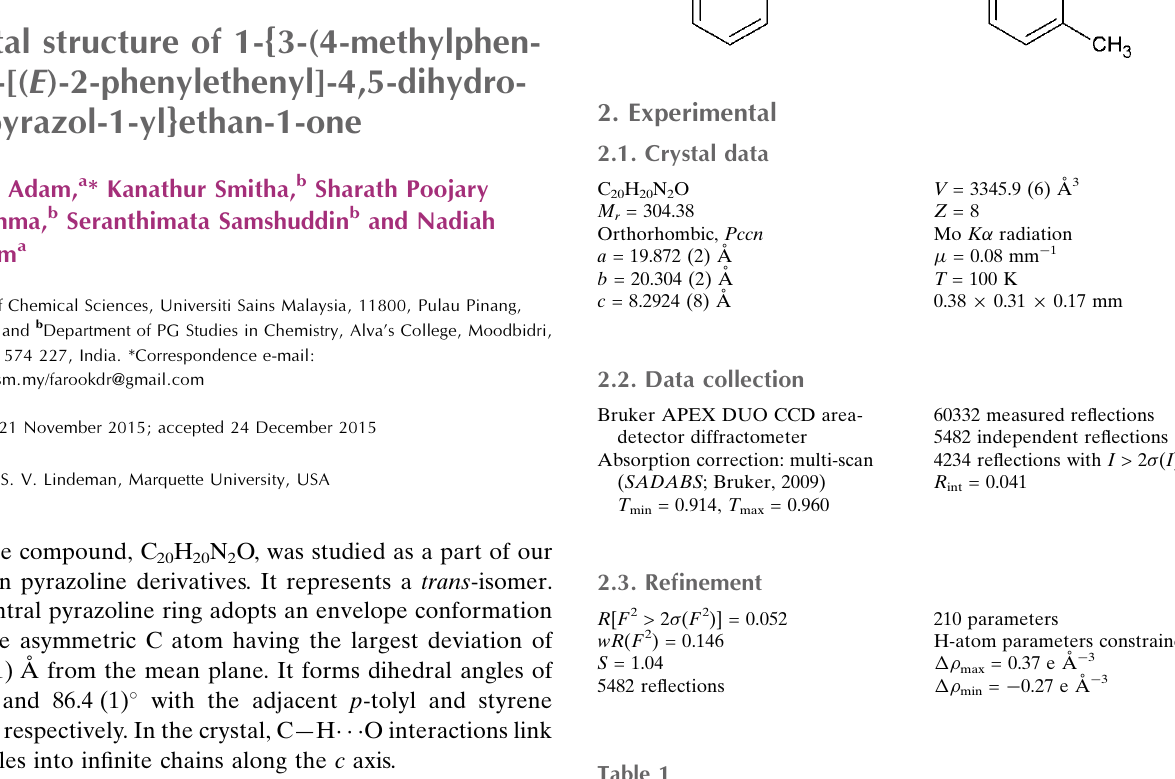
Hydrogen-bond geometry (A˚ , (cid:2)